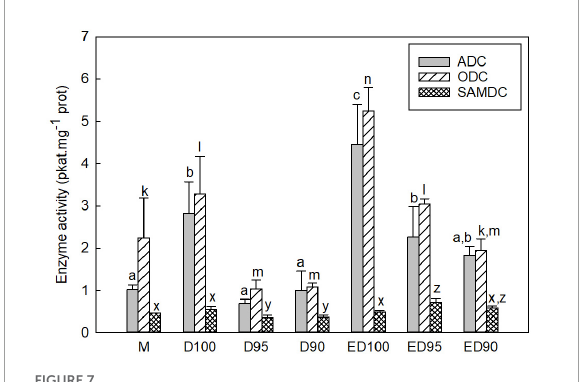
FIGURE7 Activities of PA biosynthetic enzymes ADC, ODC, and SAMDC in mature embryos (M), control embryos at half (D100) and at the end (ED100) of treatment with 100% relative humidity, and embryos exposed to 95 and 90% relative humidity during the first half of desiccation (D95 and D90) and subsequently transferred to 100% relative humidity (ED95 and ED90). ADC, arginine decarboxylase; ODC, ornithine decarboxylase; SAMDC, S-adenosylmethionine decarboxylase. Values are given as means ± standard deviations. Bars represent standard deviations of three independent experiments ( n = 6). Statistical analyzes were performed for the activities of each enzyme. Different letters indicate a statistically significant difference at p ≤ 0.05. a,b,c - ADC; k,l,m,n - ODC; x,y,z -